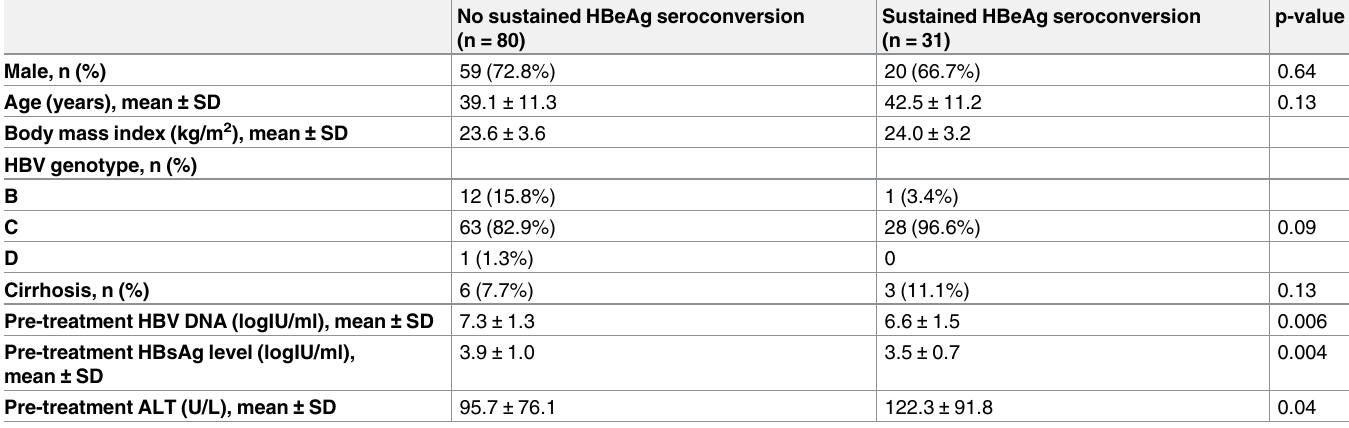
Table 1. Baseline characteristics of patients with HBeAg-positive chronic hepatitis B infection after 48 weeks of PegIFN therapy. No sustained HBeAg seroconversion (n =